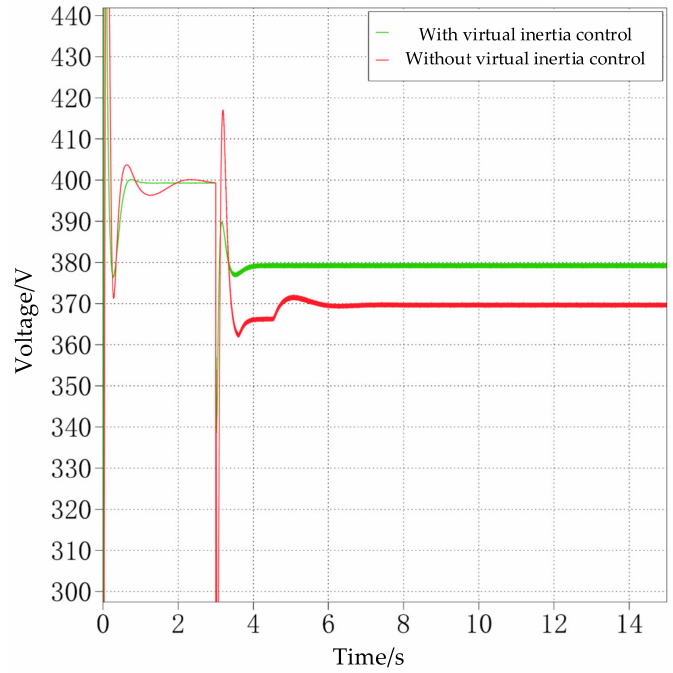
Figure 15. DC-side bus voltage waveform.